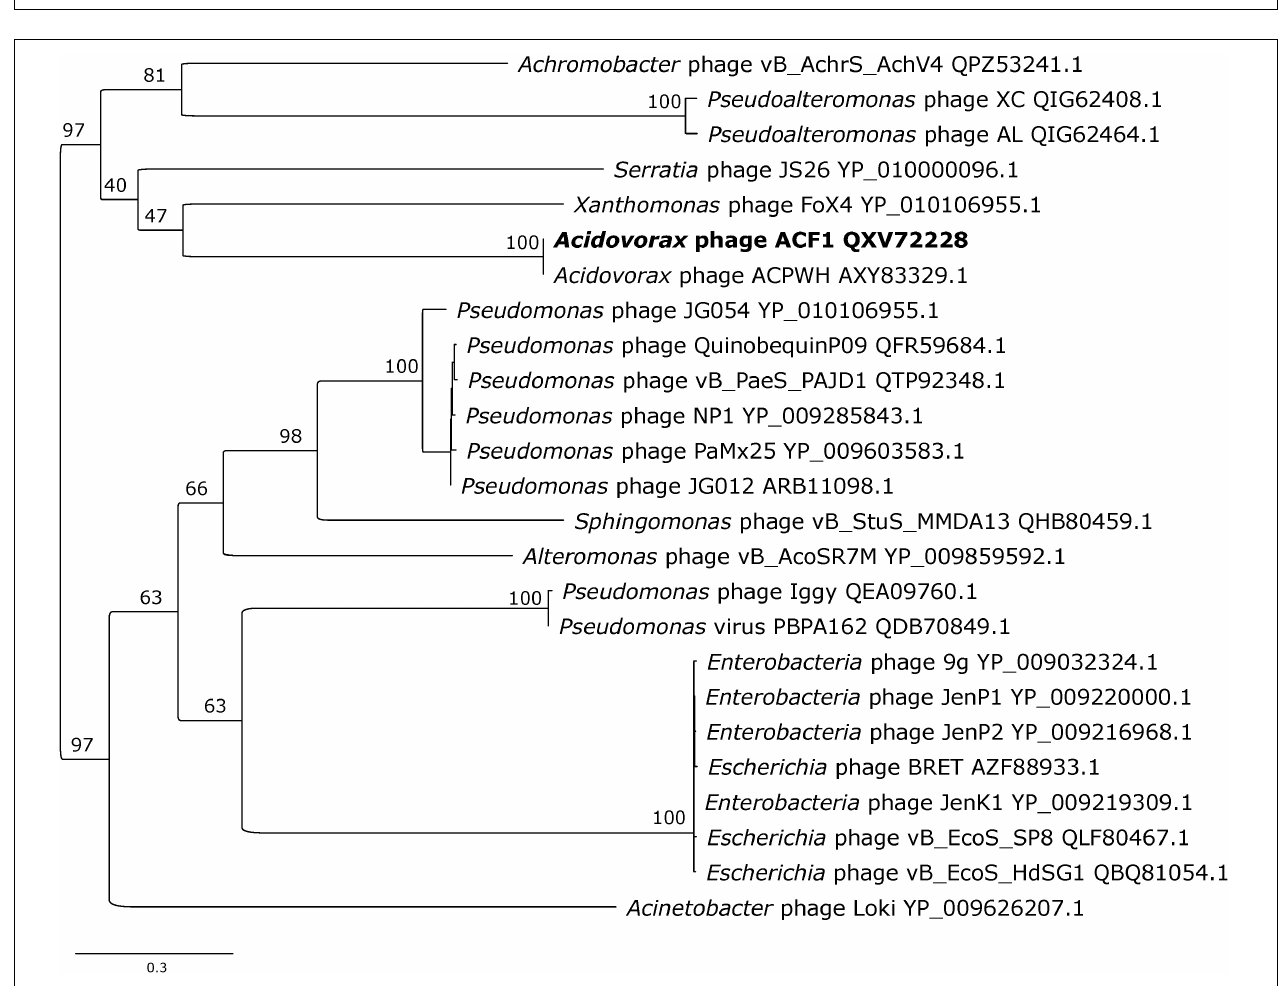
FIGURE 8 | Comparison of draft genome sequence of Acidovorax phage ACF1 and Acidovorax phage ACPWH using Easyfig. Arrows indicate ORFs and their orientation. ORFs are colored according to their functions (see Figure 7 ). The blue vertical blocks between the genome maps indicate the level of identity between sequences (see the legend on the right) according to tBLASTx.